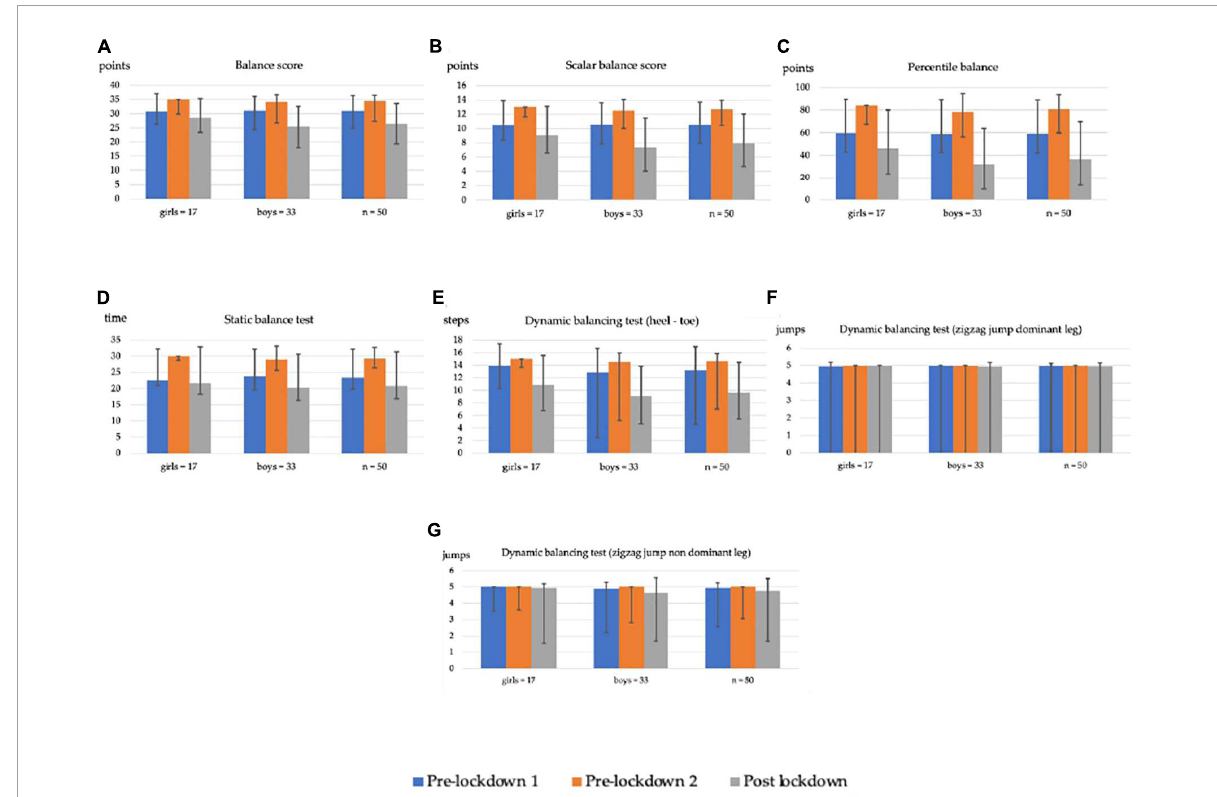
FIGURE1 Columns of the evolution of mean balance scores and their different tests with standard deviation bars. (A) Balance dimension score; (B) Balance scalar score; (C) Balance percentile; (D) Static balance test–values in seconds; (E) Dynamic balance test 1–values in steps performed correctly; (F) Dynamic balance test 2 with dominant leg–values in jumps performed correctly; (G) Dynamic balance test 2 with non-dominant leg–values in jumps performed